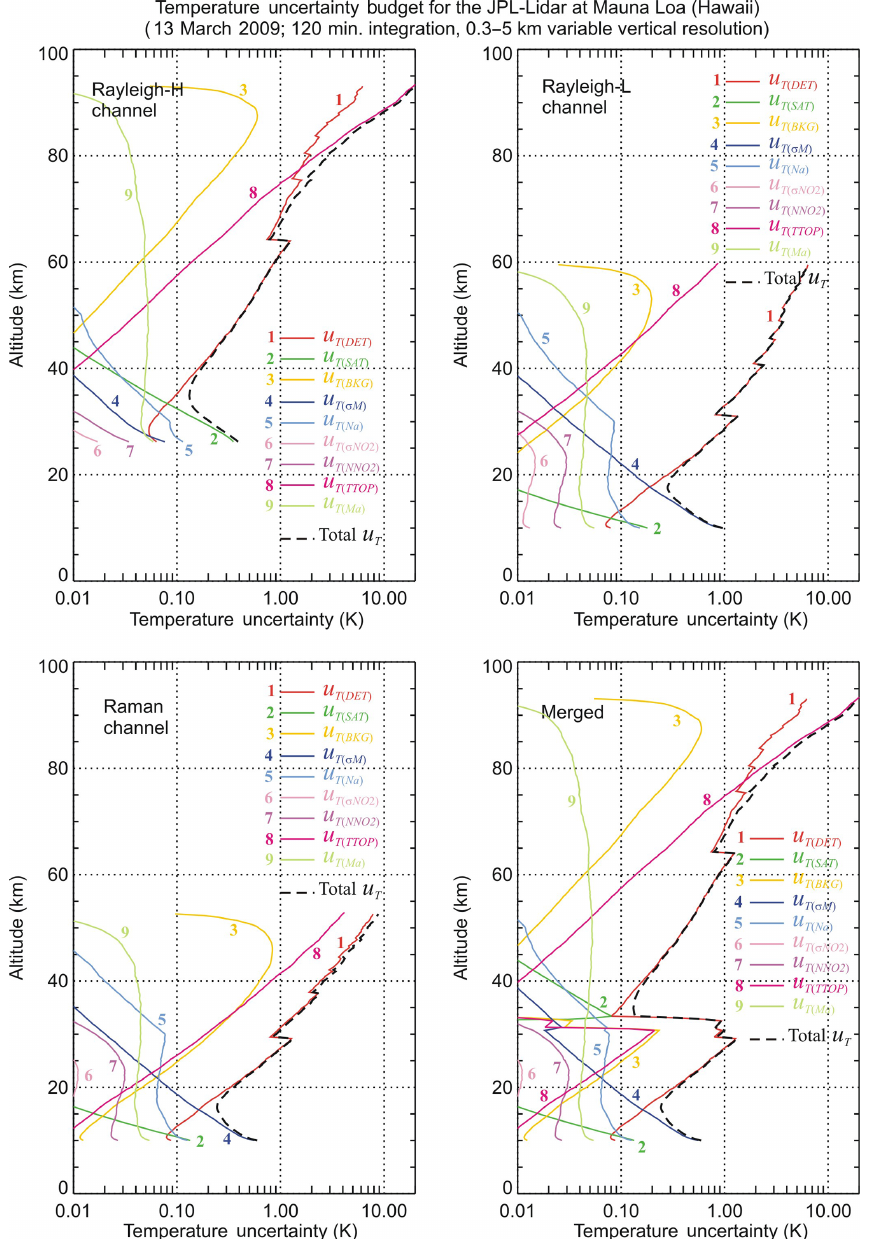
Figure 10. Example of full uncertainty budget for the JPL Mauna Loa Observatory temperature lidar, as computed using the expressions proposed in the present section (data taken during 2h on 13 March 2009). Uncertainty components are as follows: 1: detection noise; 2: saturation correction; 3: background correction; 4: Rayleigh scattering cross sections; 5: ancillary air number density; 6: NO 2 absorption cross sections; 7: ancillary NO 2 number density; 8: temperature tie-on; 9: molecular mass of air.